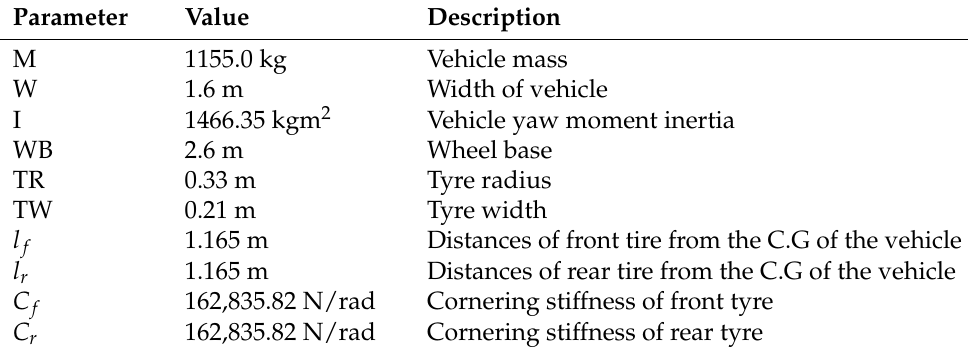
Table 1. Vehicle model parameters considered from